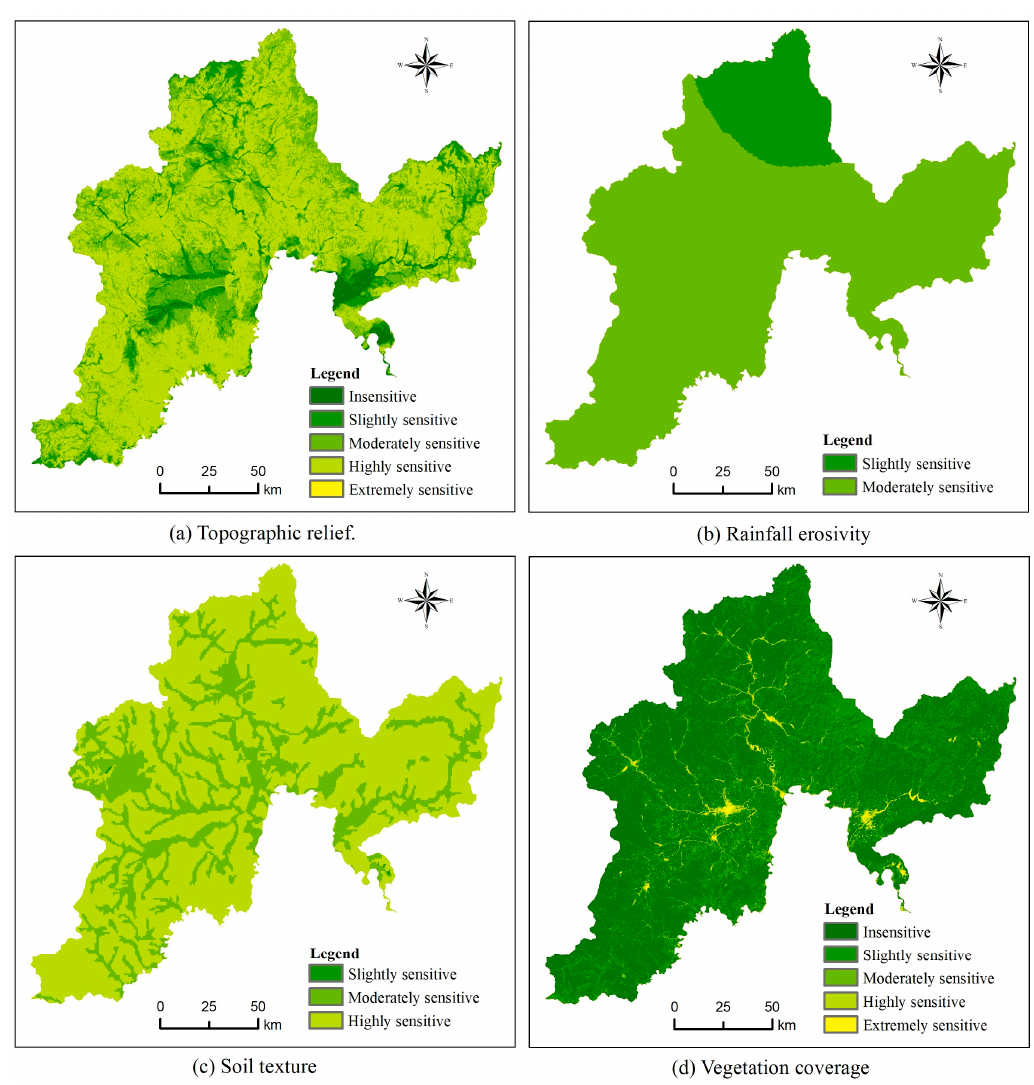
Figure 5. Distribution of ecological sensitivity of soil erosion. Table 6. Area and proportion of ecological sensitivity classification of soil